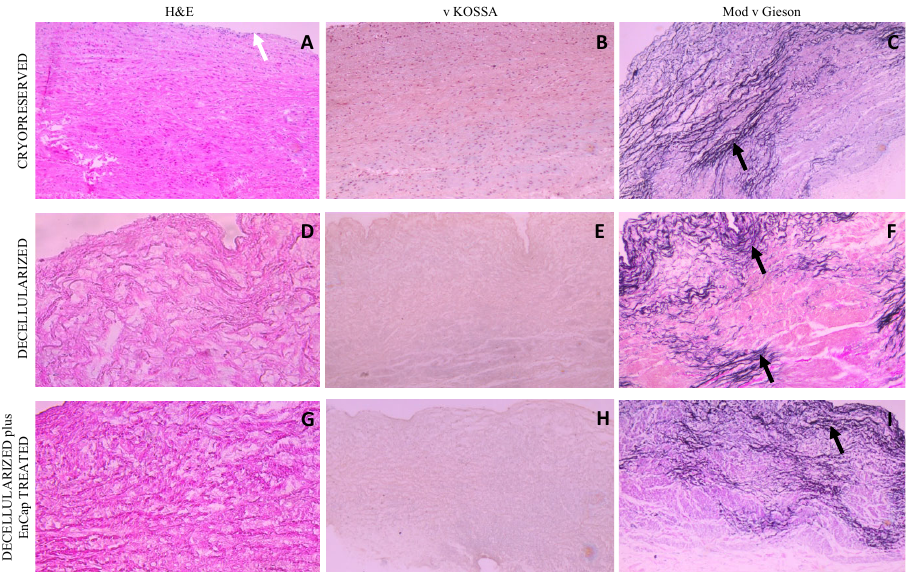
Figure 5. Representative H&E, von Kossa, and modified Verhoeff’s van Gieson staining of cryopreserved, decellularized, and decellularized and EnCap TM ‐ treated wall tissue processed after 48 h cold ischemia; white arrow points to endothelial layer, and black arrows point to normally distributed elastic fibers (( A – I ) = 100× magnification). SEM demonstrated cell dehiscence, although it did demonstrate the uniform cover ‐ age of leaflets and wall tissue with endothelial cells in the cryopreserved group (Figure 6A,B). Leaflets and walls in both the decellularized (Figure 6C,D) and decellularized plus EnCap TM ‐ treated groups (Figure 6E,F) demonstrated exposed collagen networks without any endothelial cells and only basal membrane remnants (white arrows).